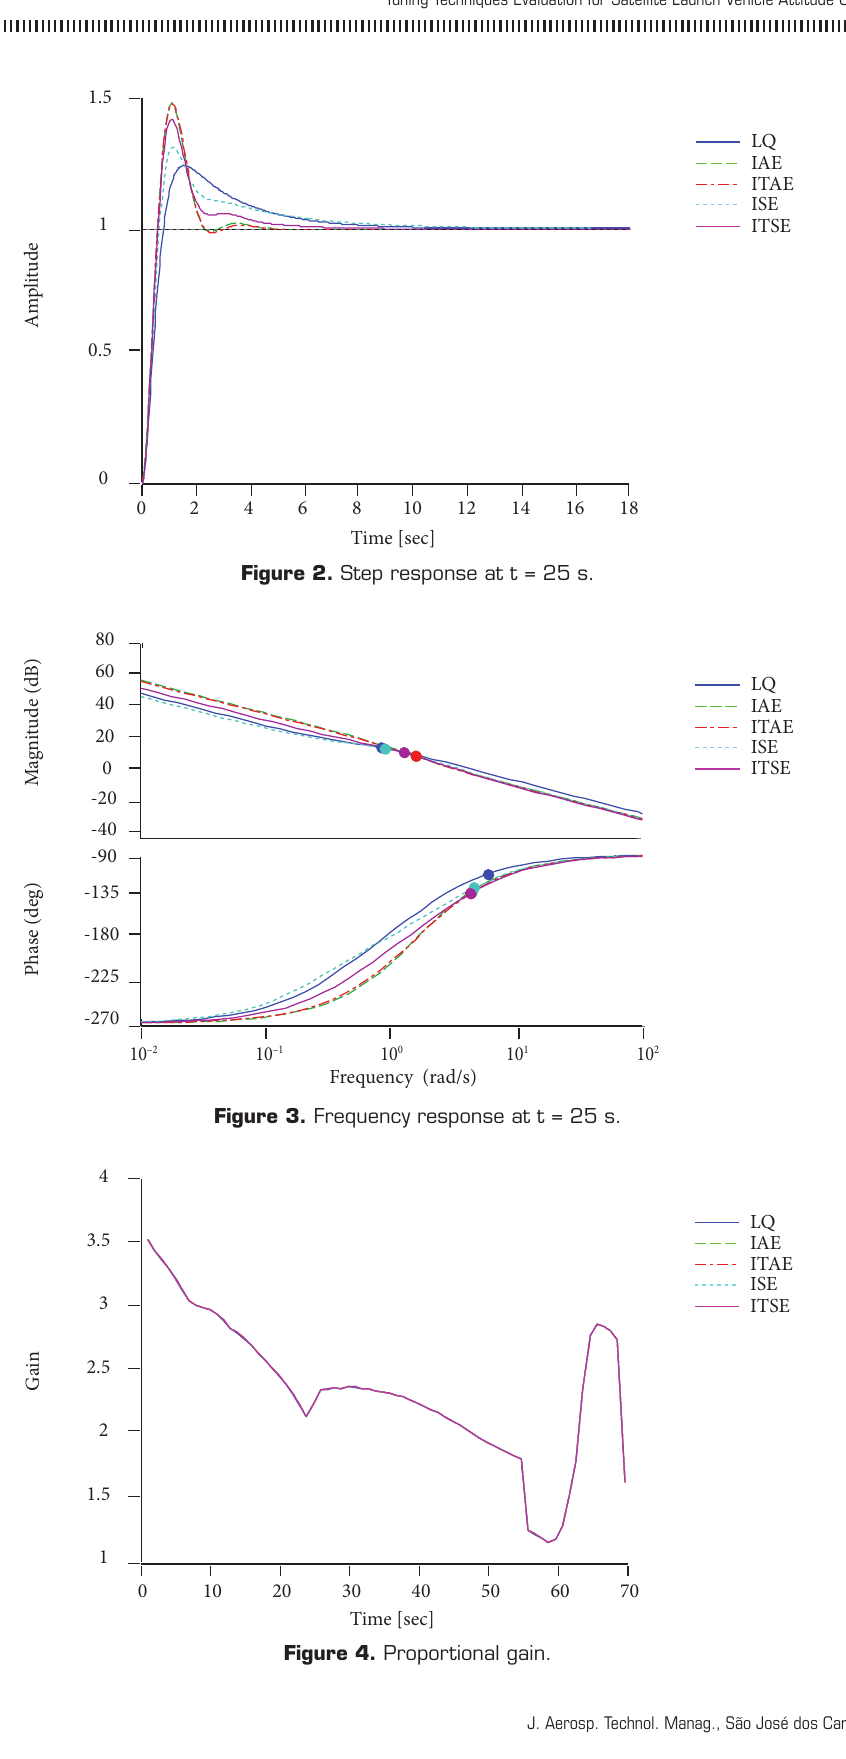
Figure 4. Proportional gain.